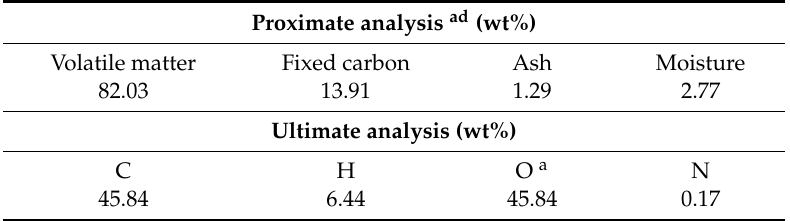
Table 1. The proximate and ultimate analysis of pine